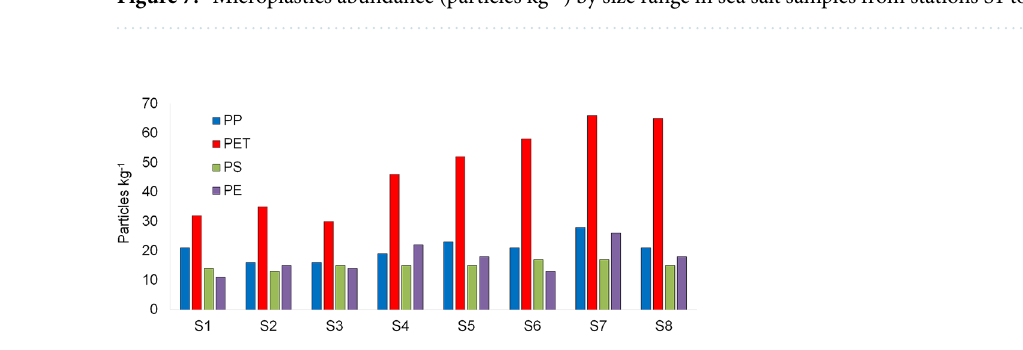
Figure 7. Microplastics abundance (particles kg −1 ) by size range in sea salt samples from stations S1 to S8.